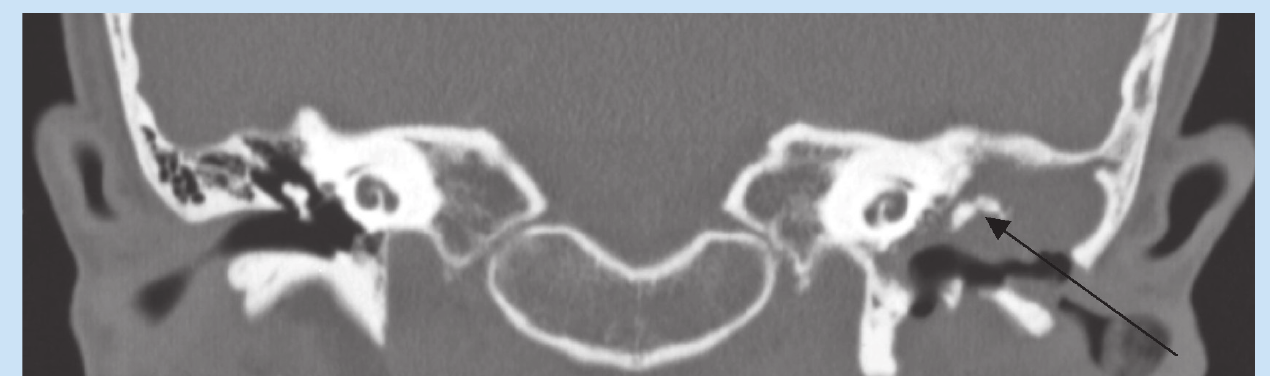
Fig. 2. Coronal CT with bony windows showing the invasive cholesteatoma eroding and displacing the incudo-malleolar complex (arrow).